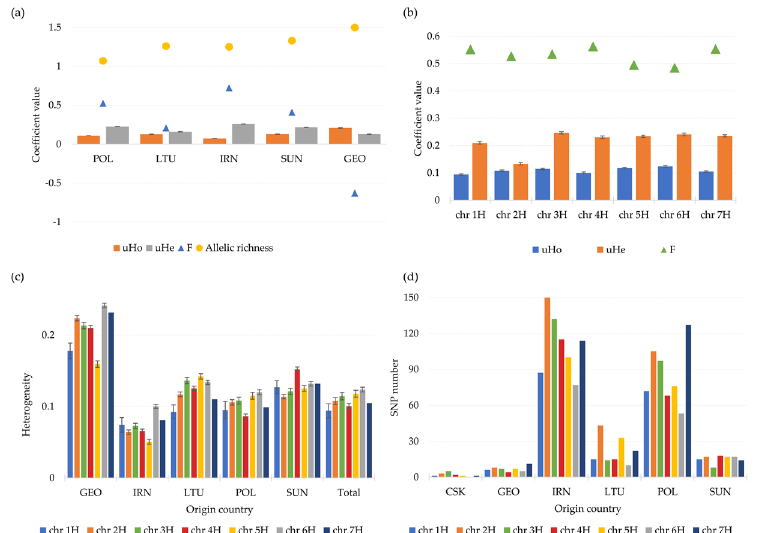
Figure 4. Diversity coefficients ( a ) unbiased coefficient of variation (uHe), unbiased observed heterogeneity (uHo), and Fixation Index (F) for 116 spring barley landraces based on DArTseq data calculated for groups of landrace in accordance with their origin; ( b ) diversity coefficients for 116 spring barley landraces based on DArTseq data, calculated for groups according to the location of the tested loci on barley chromosomes; ( c ) heterogeneity on individual chromosomes according to the country of accessions origin; ( d ) number of unique SNPs on barley chromosomes according to accession country of origin.